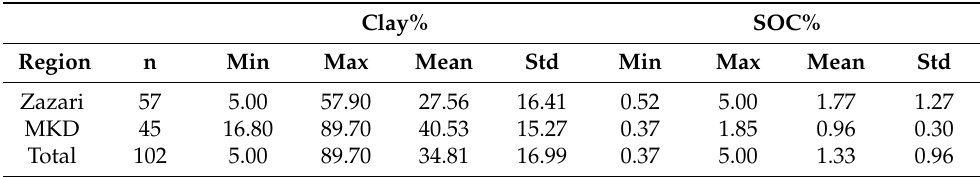
Table 1. Descriptive statistics of clay and SOC content (n = number of